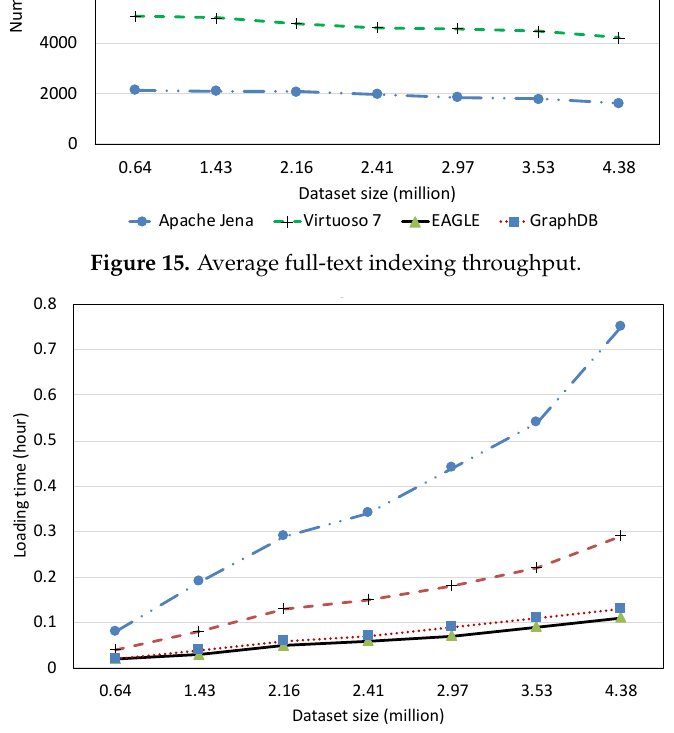
Figure 16. Text data loading